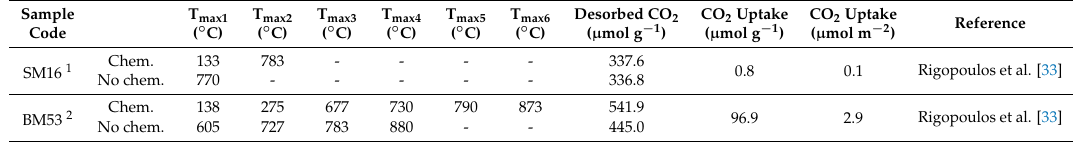
Table 4. Peak maximum desorption temperatures (T max ) and amounts of desorbed CO 2 ( µ mol g − 1 ) (after chemisorption from a 5 vol% CO 2 /He gas mixture [Chem.], and without chemisorption [No chem.]) estimated from CO 2 –TPD experiments for the starting dolerite and the ball-milled dolerite with the highest CO 2 uptake. The CO 2 uptake ( µ mol g − 1 ), which reflects the quantity of carbonate species formed on the surface of the samples following chemisorption, is the difference between the amounts of desorbed CO 2 after chemisorption and without chemisorption. The CO 2 uptake per unit area of solid ( µ mol m − 2 ) was also calculated after dividing the amount of CO 2 uptake per gram basis ( µ mol g − 1 ) to the BET specific surface area (m 2 g − 1 ) of each solid (BET values are given in Table